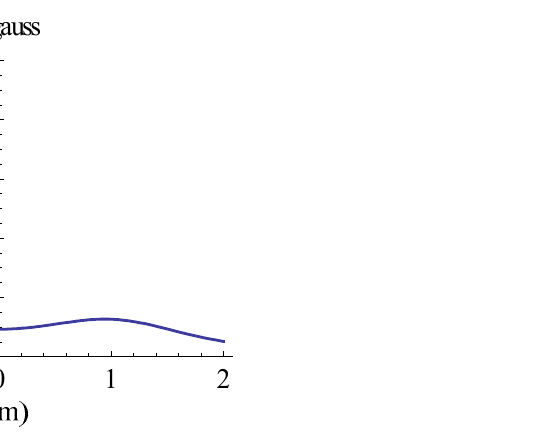
Figure 8. The simulation results of B fields of the square Helmholtz coil in the y-z plane.